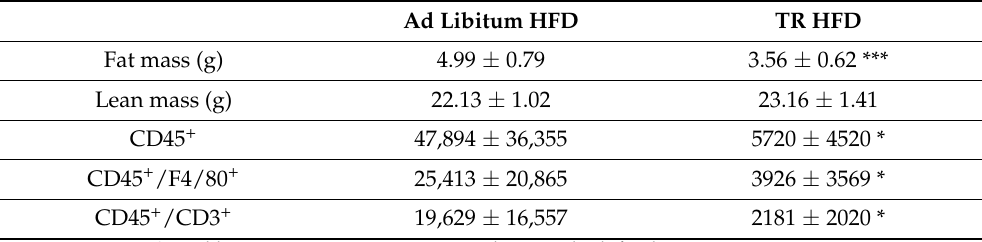
Table 2. Body composition and adipose tissue (eAT) immune cells of HFD fed